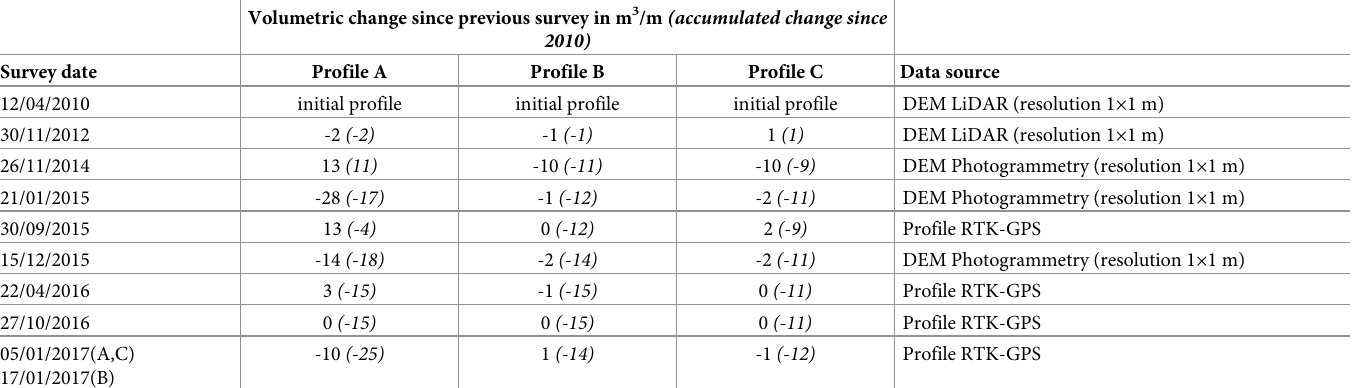
Table 1. Dune volume changes between consecutive measurements. A summation of the changes since the first topographic observation in 2010 is given within brackets. Volumetric change since previous survey in m 3 /m (accumulated change since